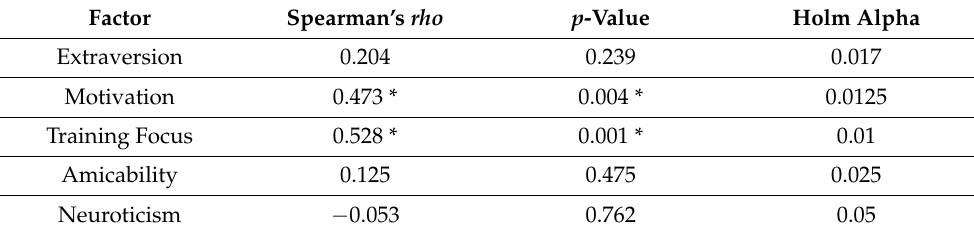
Table 6. Correlations between overall working performance score and work behaviour factors with calculated correlations and significance with Holm–Bonferroni correction. Factor p -Value